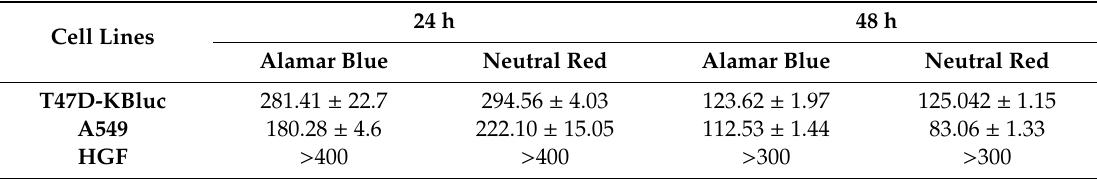
Table 7. IC 50 values ( µ g extract / mL) obtained by Alamar Blue and Neutral Red assays for T47D-KBluc, A549, and HGF at 24 h and 48 h post-exposure.